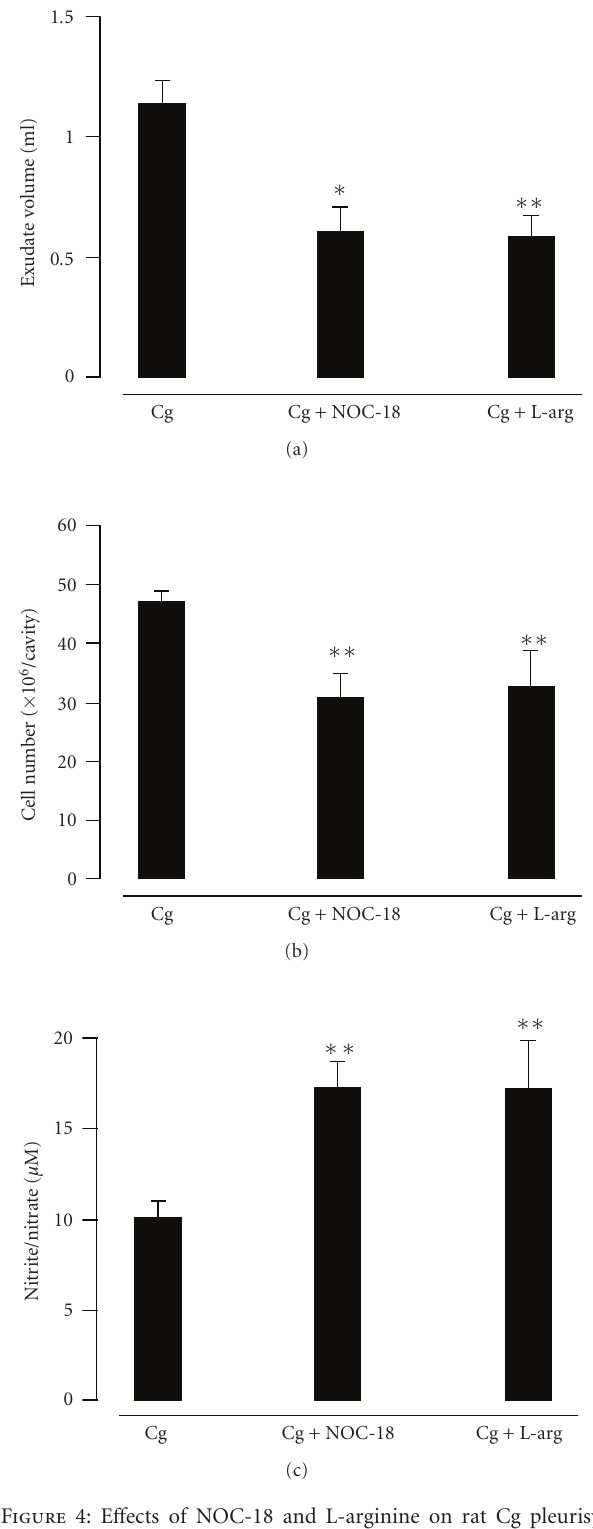
Figure 4: E ff ects of NOC-18 and L-arginine on rat Cg pleurisy and nitrite/nitrate levels. NOC18 or L-arginine was injected into the pleural cavity immediately before Cg injection. The exudate volume (a), cell number (b), and nitrite/nitrate levels (c) in the pleural exudates were determined 6 hours after Cg injection. Data are expressed as mean ± S.E.M. of 6 to 8 rats. ∗ P < . 05, ∗∗ P < . 01 as compared to the Cg group.